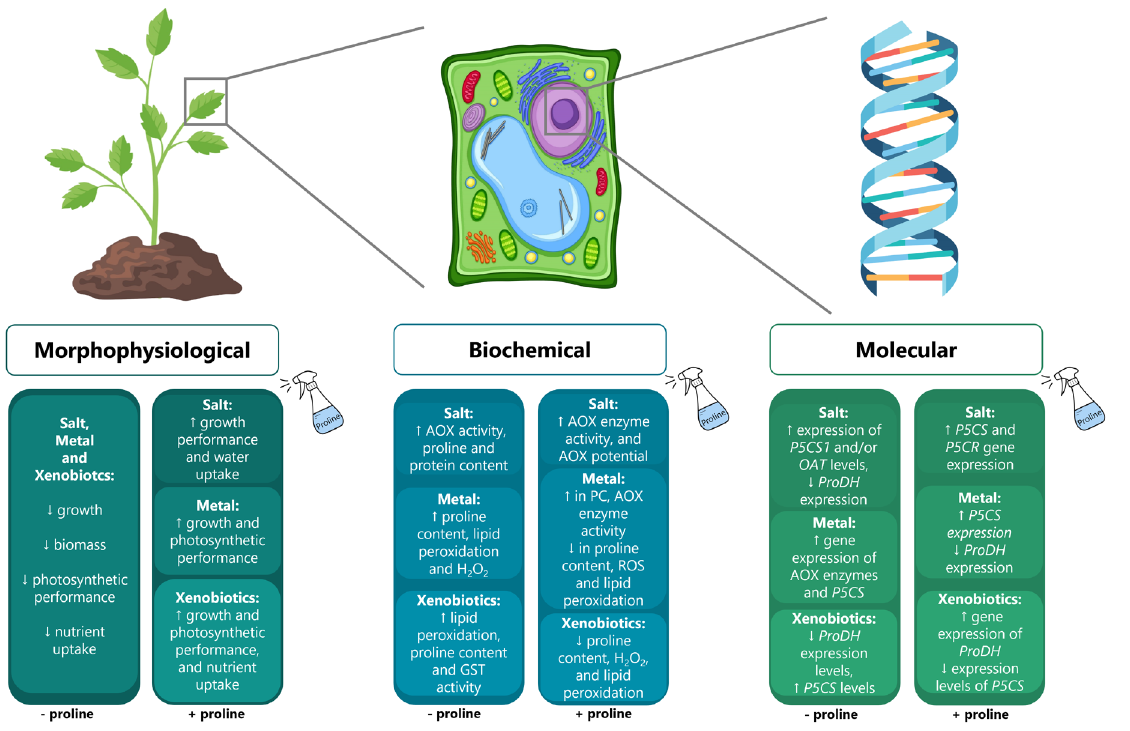
Figure 2. Common effects observed in plants exposed to conditions of salinity, metal contamination, and pollution by xenobiotics at morphophysiological, biochemical, and molecular levels (left boxes) in comparison to the response of stressed plants to the exogenous application of proline (right boxes). ↑ and ↓ symbolize the reported increase or decrease of a certain parameter, respectively.